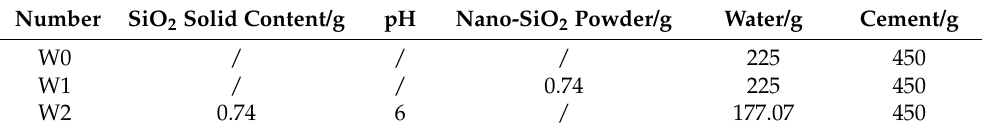
Table 8. Specific mixing